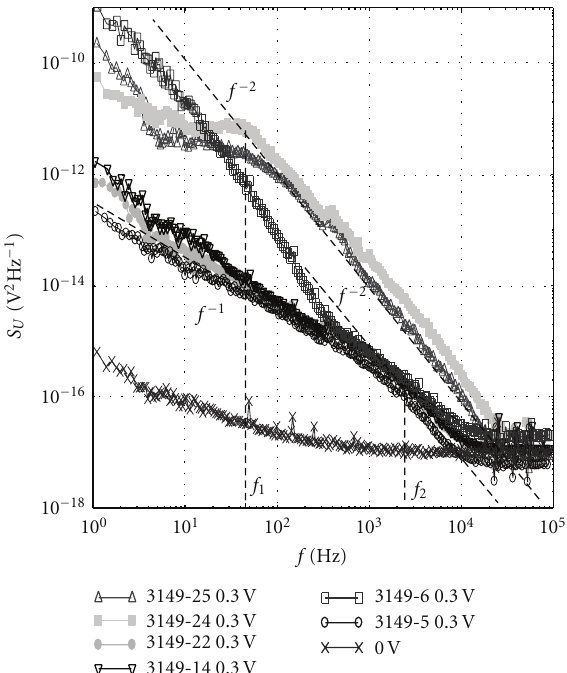
Figure 3: The noise spectral density versus frequency for group of samples 3149.